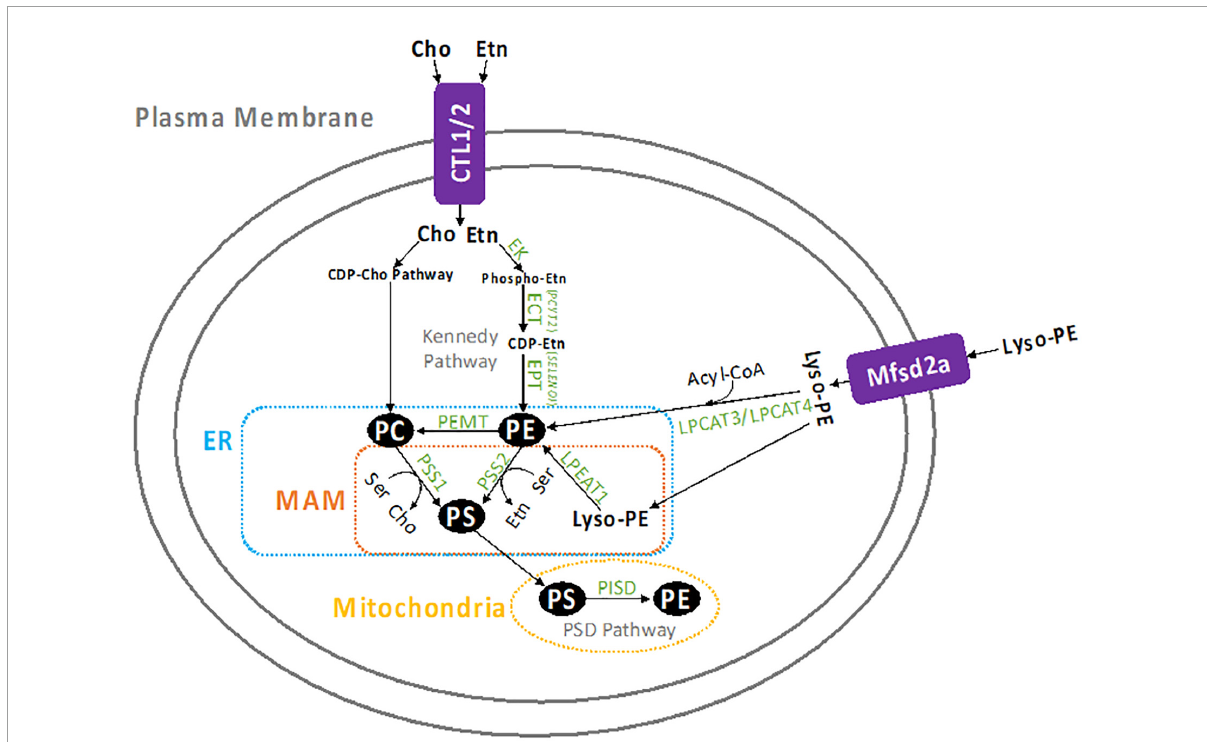
FIGURE1 Summary of PE metabolism. Etn enters the cell by CTL1 or CTL2, where it is converted to PE by the CDP-Etn branch of the Kennedy pathway. First Etn is converted to phosphoethanolamine and then to CDP-Etn by ECT ( PCYT2 ), which is the rate limiting step in this pathway. CDP-Etn is converted to PE by the EPT ( SELENOI ). Cho is similarly used to produce PC through the CDP-Cho branch of the Kennedy pathway. Once created, PE can be converted to PC by the PEMT enzyme (mostly in the liver), or to PS by PSS2 in the MAM. The PS can be transported to the mitochondria to be decarboxylated and form PE, which is catalyzed by the PISD enzyme. Similarly, PC can be converted to PS by PSS1 in the MAM, then decarboxylated by PISD in the mitochondria to form PE. Lyso-PE can also form PE when it is transported into the cell by the Mfsd2a transporter, the acylated by LPEAT1 in the MAM, or LPCAT2, or LPCAT3 in the